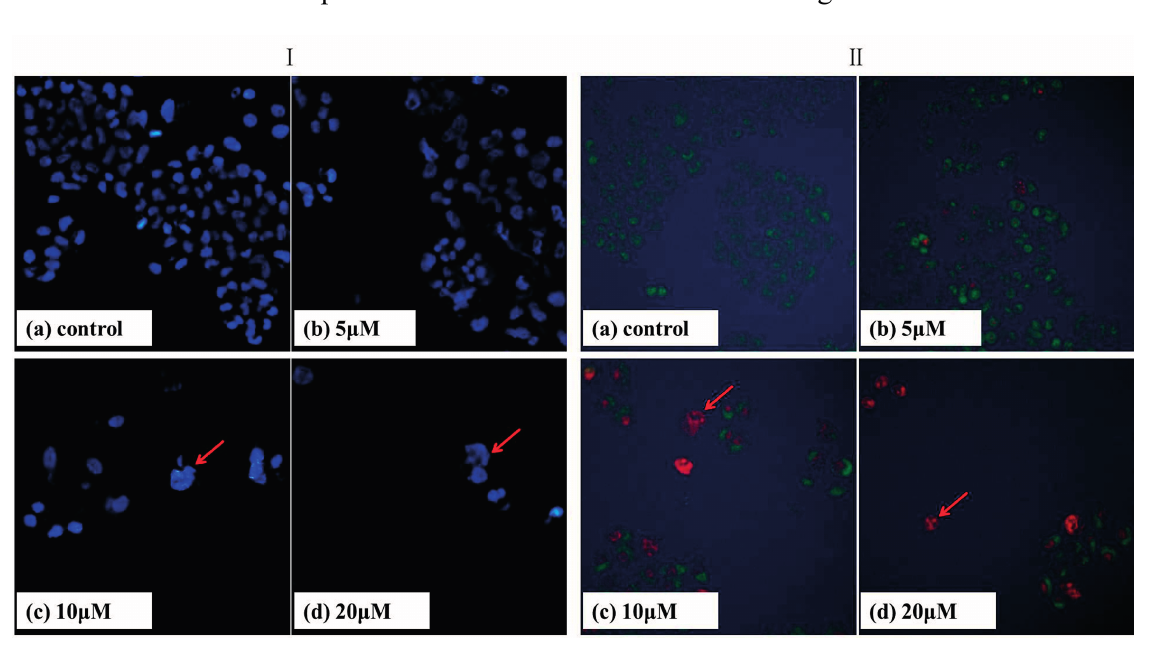
Figure 4. DAPI ( I ) and acridine orange/ethidium bromide (AO/EB) ( II ) staining of the Bel-7402 cells treated by T-OA. ( Ia ) Control group without T-OA; ( Ib ) Treated with 5 µM T-OA; ( Ic ) Treated with 10 µM T-OA; ( Id ) Treated with 20 µM T-OA; ( IIa ) Control group without T-OA; ( IIb ) Treated with 5 µM T-OA; ( IIc ) Treated with 10 µM T-OA; ( IId ) Treated with 20 µM T-OA. (×200)